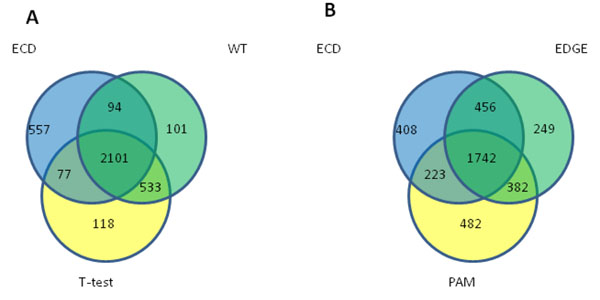
Venn diagrams illustrating the degree of overlap between the statistically significant probe sets identified by the Modified Wilcoxon test, with the corresponding probe sets identified by other methods (WT, t-test, PAM and EDGE). Panel A: Venn diagram illustrating the overlap between the MWT classifier and the top 2,829 differentially expressed probe sets, rank ordered using FDR values and identified using canonical approaches (t-test and WT with FDR correction). Panel B: Venn diagram depicting the overlap between the MWT classifier and the top ranked probe sets identified using computationally intensive feature selection methods.